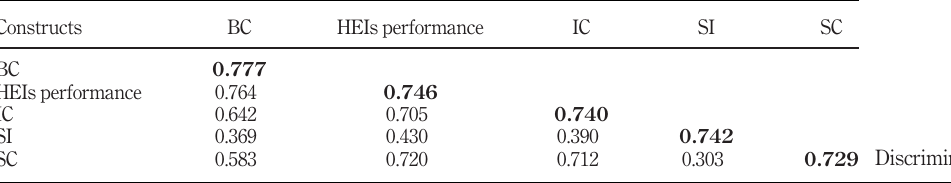
Table III. Discriminant